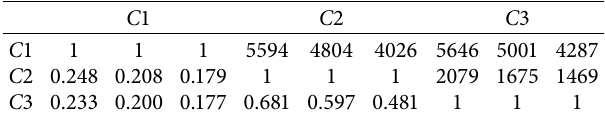
Table 3: Pairwise comparison matrix of the main criteria of the research.